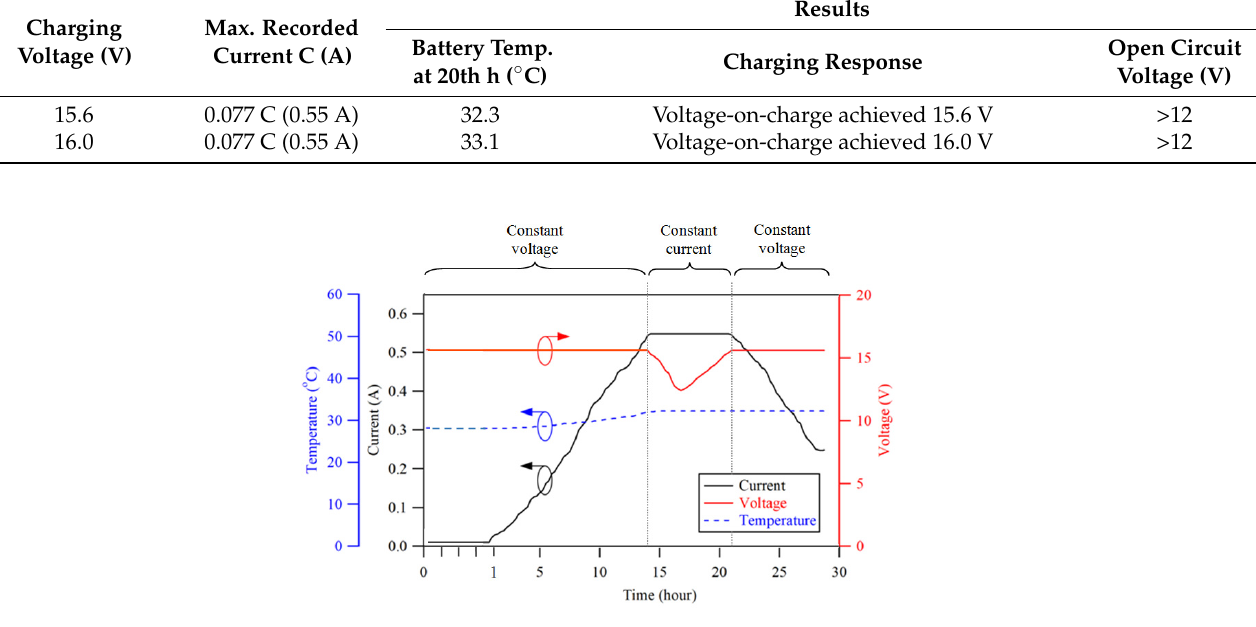
Figure 7. Scenario three: ( a ) charging response of the short-circuited batteries when charging at 15.6 V; ( b ) an expanded positive grid short with the negative lug.